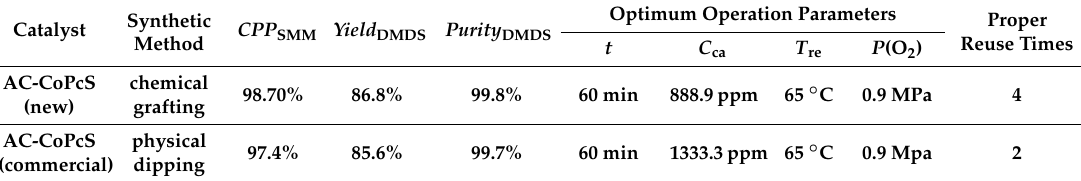
Table 3. The performance comparison between commercial and newly-prepared AC-CoPcS catalysts.